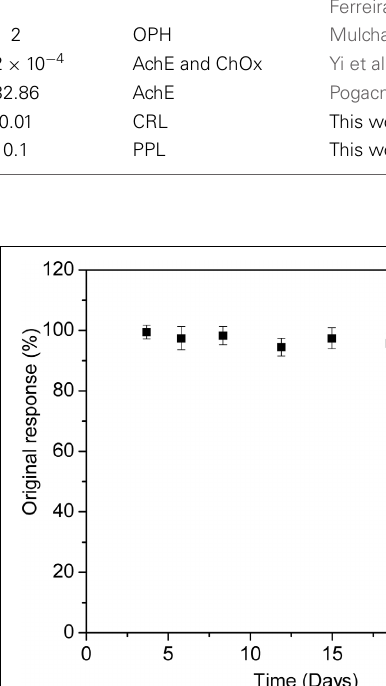
FIGURE 8 | Interference study using CRL impedimetric biosensor. Experiments were performed in 20mM PBS solution, pH 5.2 at room temperature. Each point is the mean of three values. FIGURE 9 | Stability of enzymatic biosensor, response to 50